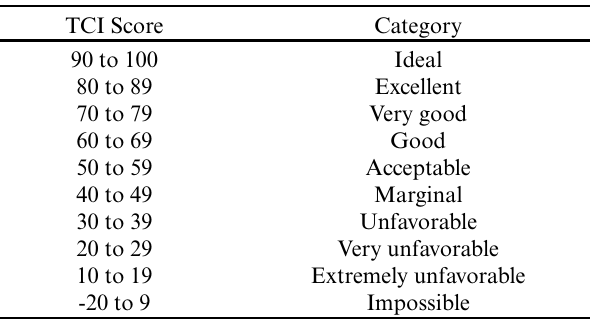
Table 2 . Rating categories for the Tourism Climate Index (TCI; ECLAC, 2011).